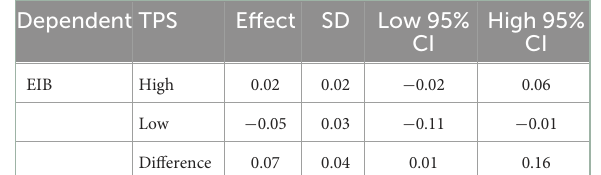
TABLE 5 Moderated mediation